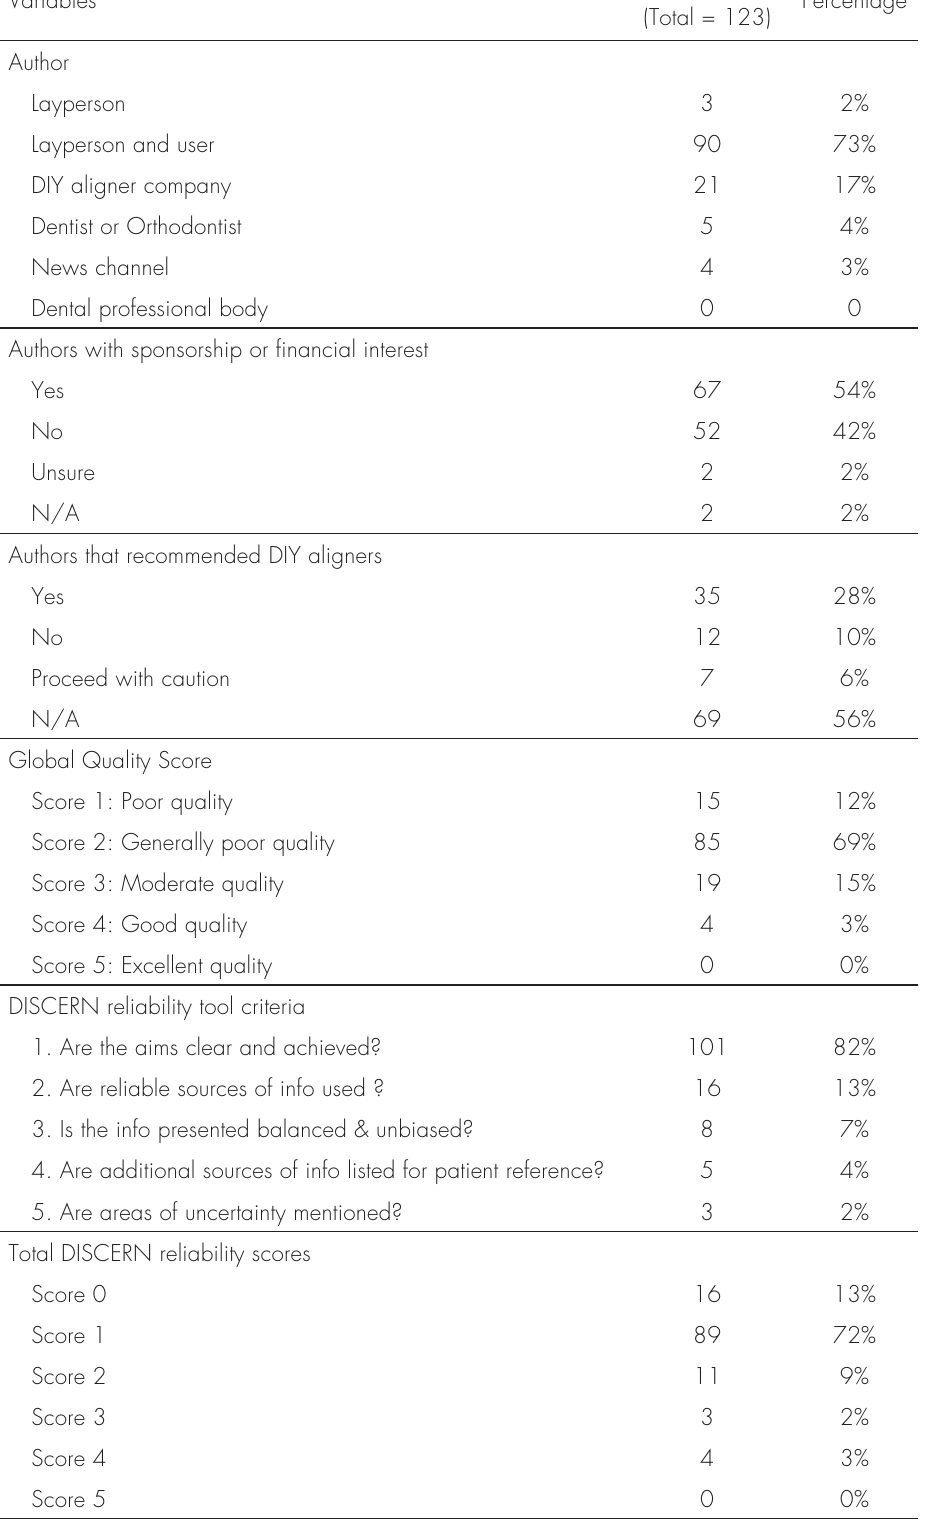
Table IV. Descriptive statistics of assessed videos. The cumulative results from each video assessment are expressed as the number (n) of videos or as a percentage of the total number of videos Variables